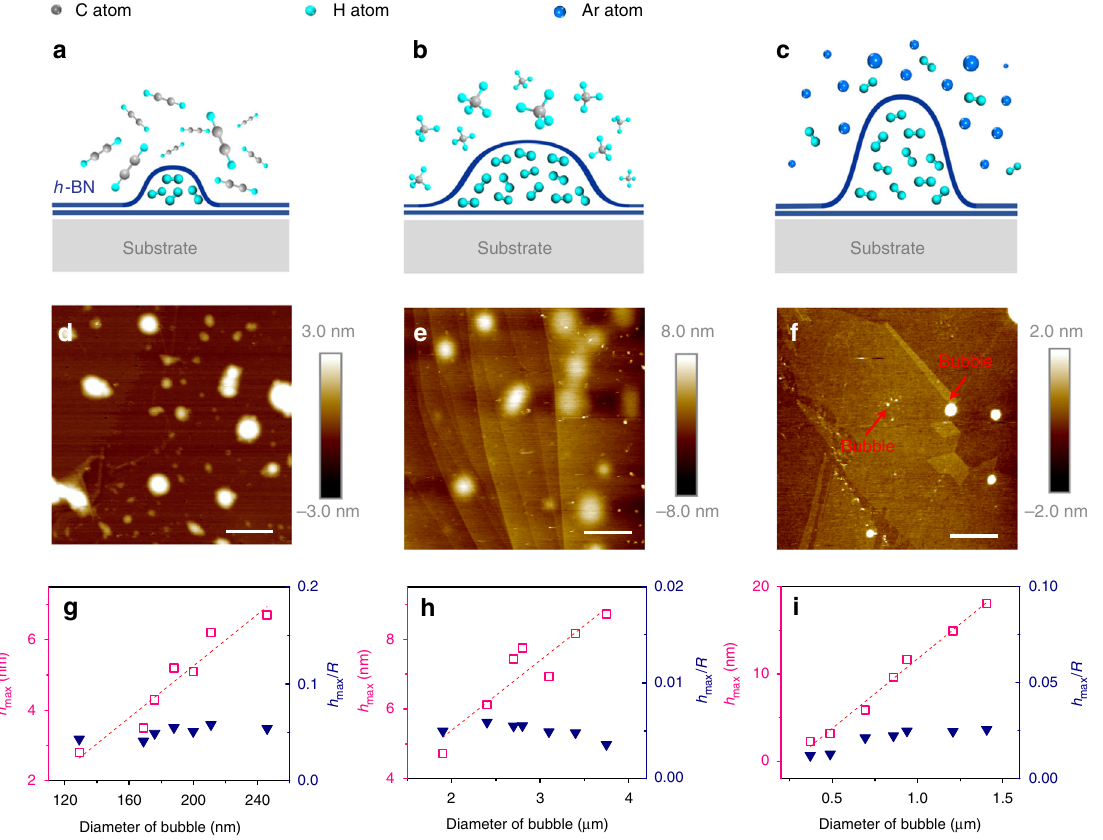
Fig. 7 Extracting hydrogen from hydrocarbon and mixture gases. a – c Schematic illustration of the separation of atomic hydrogen from ethyne (C 2 H 2 ), methane (CH 4 ) and a mixture of hydrogen and argon (Ar + H 2 , 5% H 2 ) by an h -BN membrane via plasma treatment. d – f AFM height images of the h -BN surfaces treated by a typical plasma process (350 °C, 100 W, 120 min, ~3 sccm, ~3 Pa) in an environment of ethyne, methane and a mixture of hydrogen and argon. Scale bars: d 600 nm, e , f 4 μ m. g – i h max of the bubbles fabricated via the plasma treatment in C 2 H 2 , CH 4 and Ar + H 2 (5% of H 2 ), respectively, and their aspect ratios as a function of the bubble